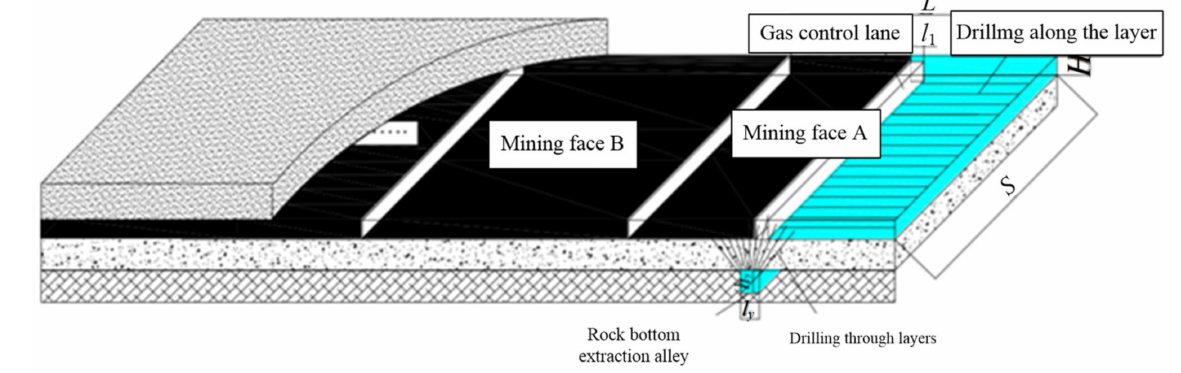
Figure 2. Establishment of mining area